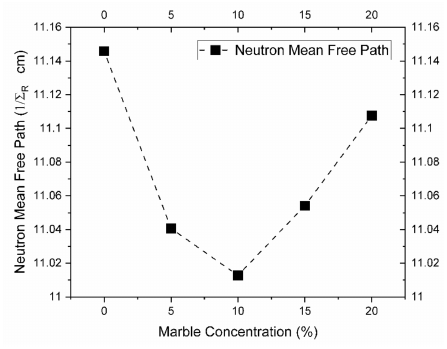
Figure 9: The Neutron MFP and marble concentra-